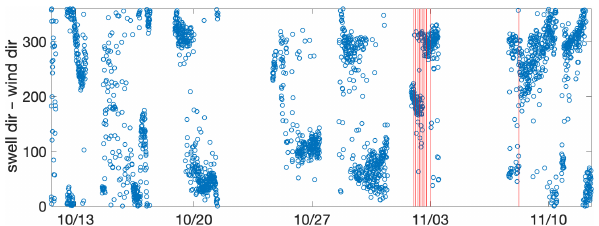
Figure A2. The angular difference between 10min averages of the wind direction and the direction of the dominant swell. The red lines show the times when measurements of the time difference between plume appearance at 2 and 4m were taken. No offset measurements were possible for the deployment between 24–27 October because no resonator data are